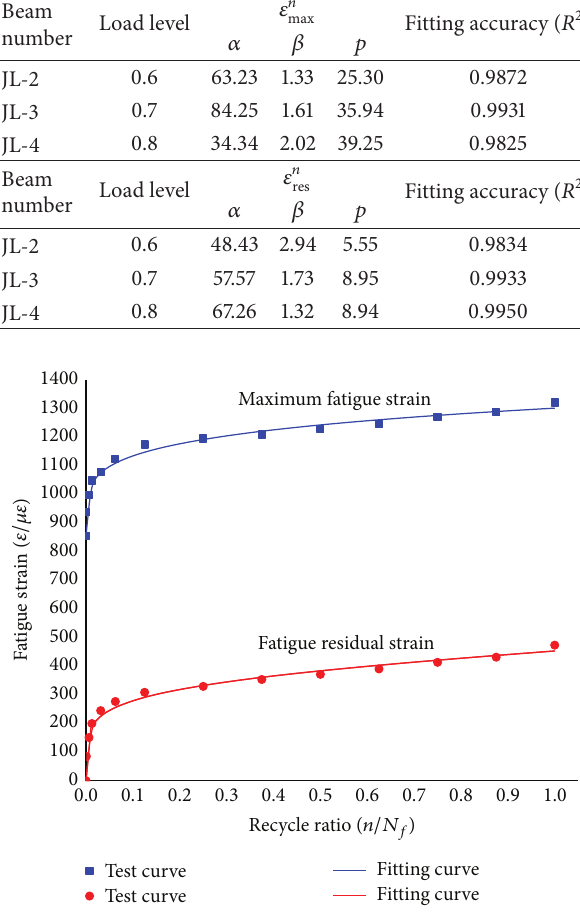
Test curve Test curve Figure 3: Testing and fitting results of fatigue strain of JL-2.